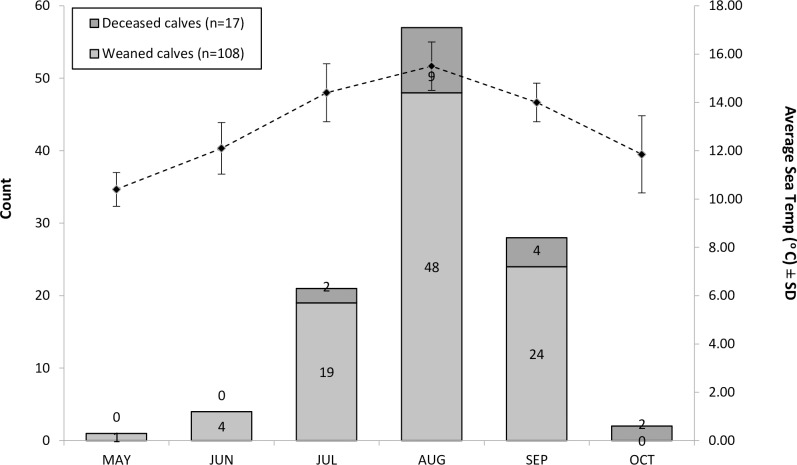
The seasonality of bottlenose dolphin births in the outer southern Moray Firth and the average monthly sea temperatures measured during encounters.